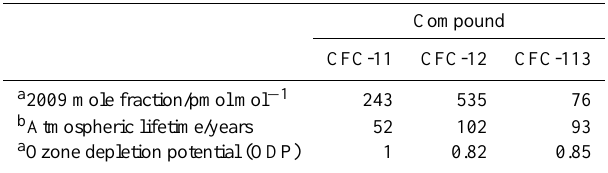
Table 1. Key atmospheric characteristics of CFC-11, CFC-12 and